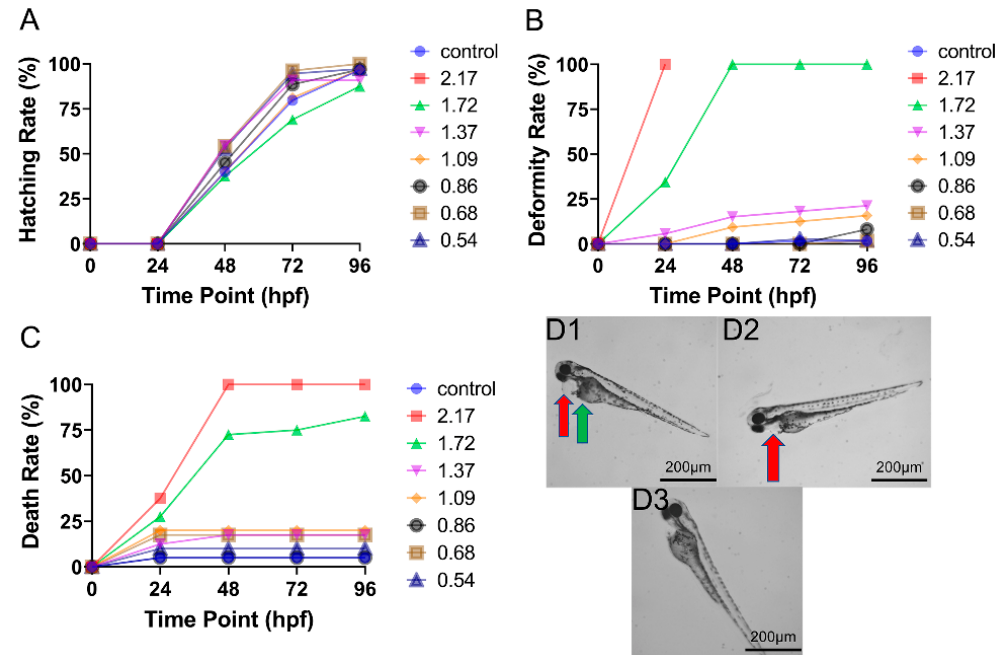
Figure 3. Effects of CAR plus ENF (MIX) on zebrafish development (n = 60). ( A ) Time–response curves of hatching rate at all tested doses. ( B ) Time–response curves of deformity rate at all tested doses. ( C ) Time–response curves of death rate at all tested doses. ( D ) Typical deformities induced by ( D1 ) 1.72 mg/L, ( D2 ) 0.86 mg/L, and ( D3 ) 0.54 mg/L MIX at 96 hpf. Red arrows demarcate areas of pericardial oedema, green arrows demarcate regions of yolk sac oedema, and blue arrows indicate regions of spinal curvature.